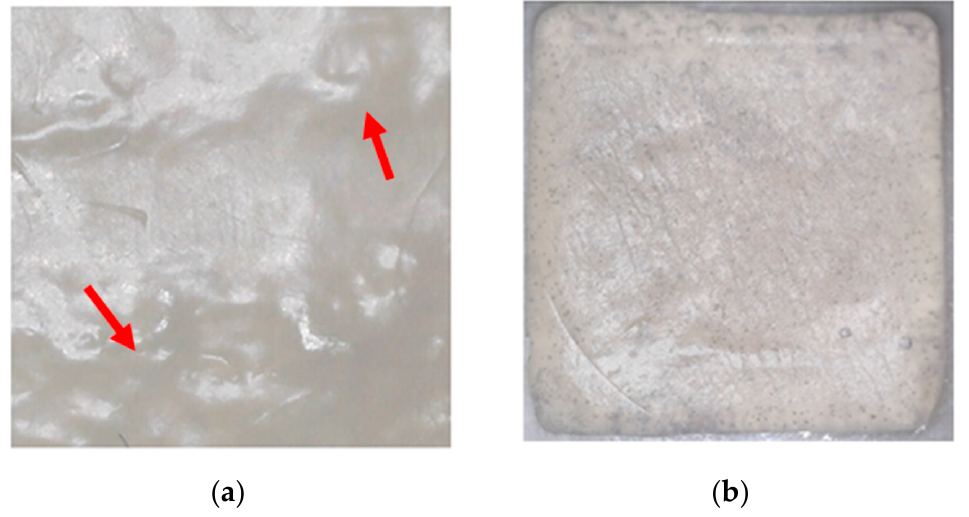
Figure 4. ( a ) Optical microscopy image of the non-loaded 3D-printed film and ( b ) non-loaded 3D- printed film after cross-linking with 10% CaCl 2 solution. Red arrows show the defects on the surface of the film.